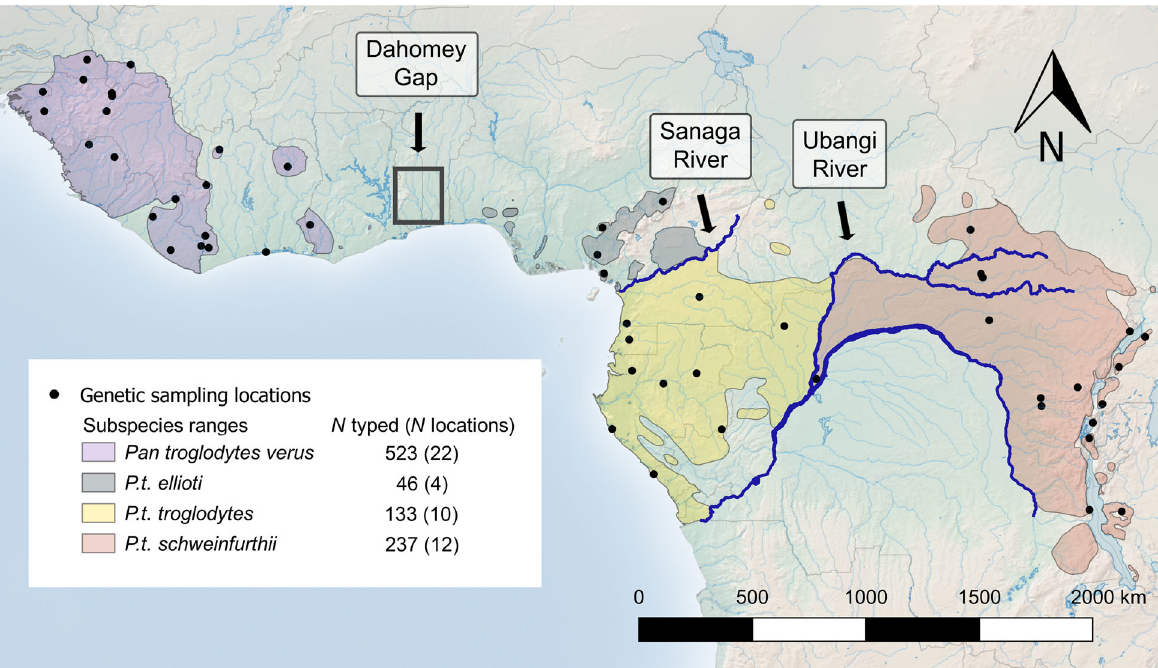
Fig. 1 Distribution map of P. troglodytes and PanAf sampling. The current approximate chimpanzee subspecies ranges 1 , sample collection locations and proposed subspecies geographic barriers. Total number of genotyped individuals and number of sampling locations are listed for each subspecies population. Much of the historical population located between P. t. ellioti and P. t. verus populations have been extirpated, creating an extensive sampling gap in the data. Note, samples collected during nationwide studies in Liberia and Equatorial Guinea were included in our spatially explicit analyses and are indicated here as the geographic centre points of the sampling